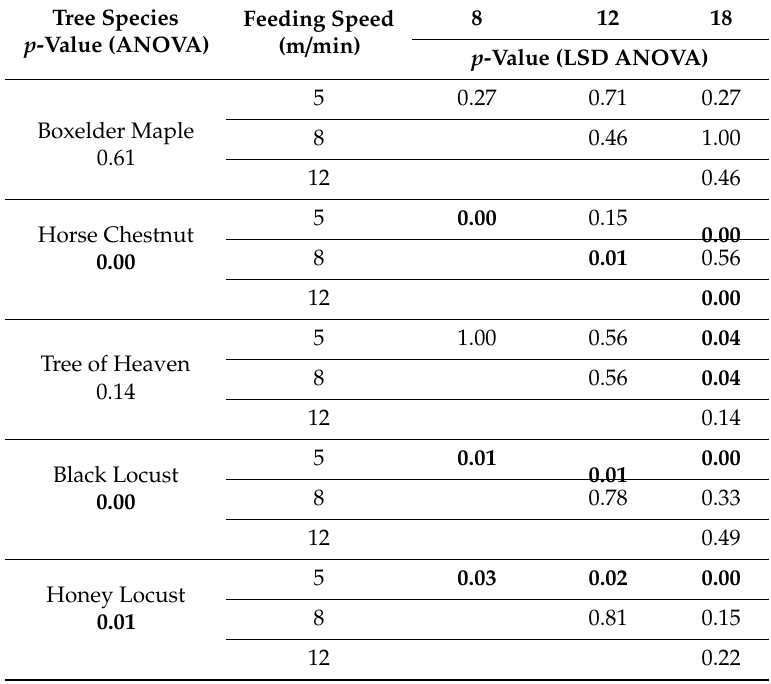
Table 2. Statistical di ff erence of the planing surface quality grades between feeding speeds for di ff erent tree species expressed by the p -value of the least significant di ff erence (LSD) analysis of variance (ANOVA) analysis. The values in bold indicate a significant di ff